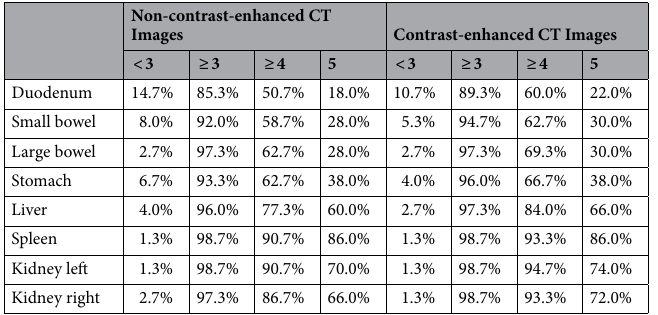
Table 3. Qualitative scores for contours generated on contrast-enhanced and non- contrast-enhanced CT images of 75 randomly selected patients.